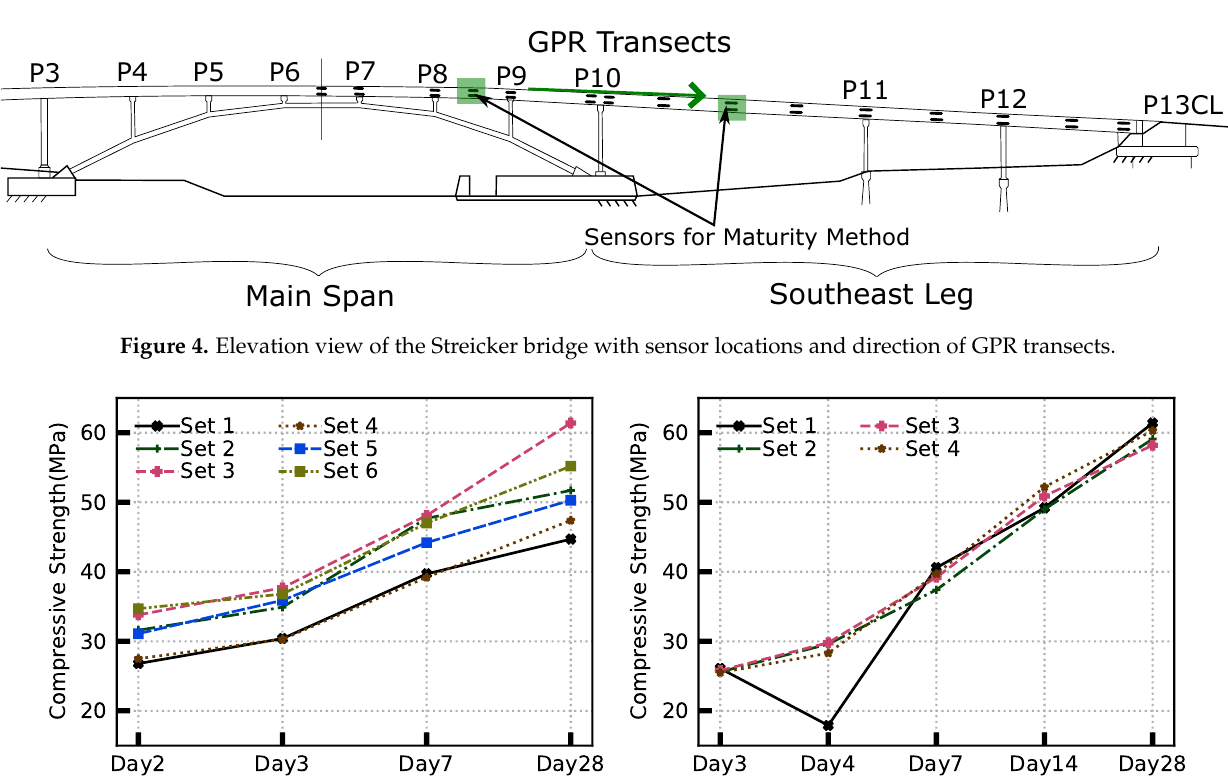
Figure 3. A single fiber-optics sensor present as part of the SHM system in the Streicker bridge (Adapted from [4]).